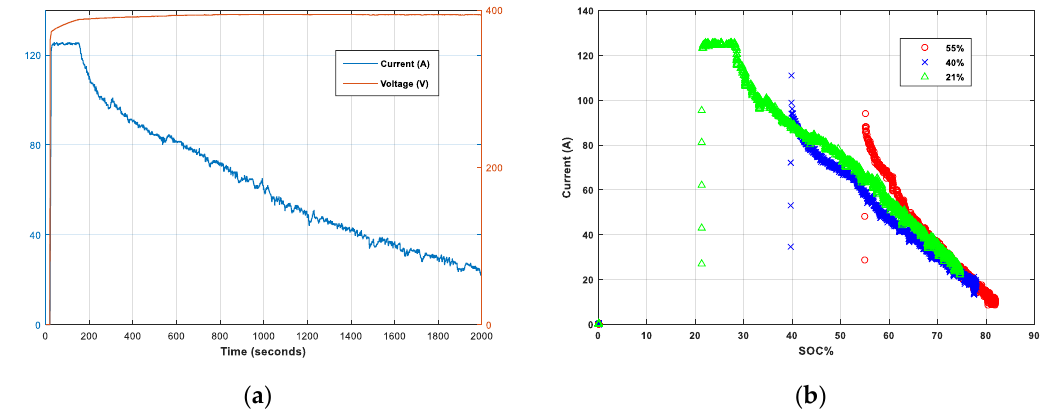
Figure 7. The charging equipment at ENEA labs.